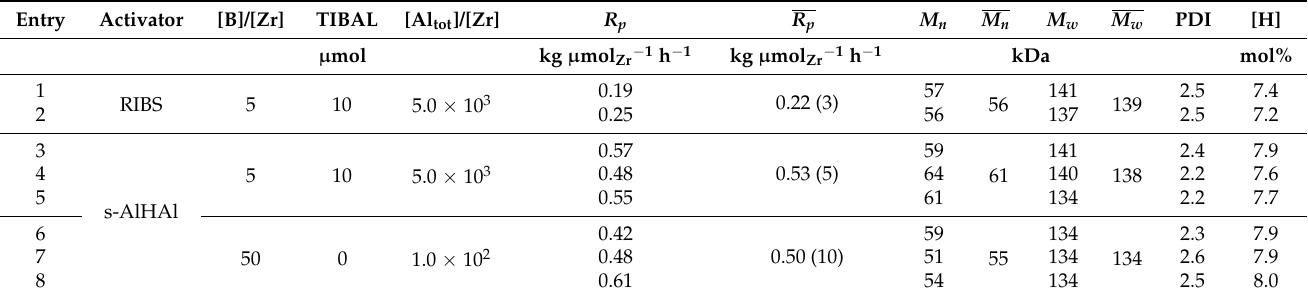
Table 1. Ethene/1-hexene copolymerization results with precatalyst Cat-Zr in combination with different cocatalysts (a) .